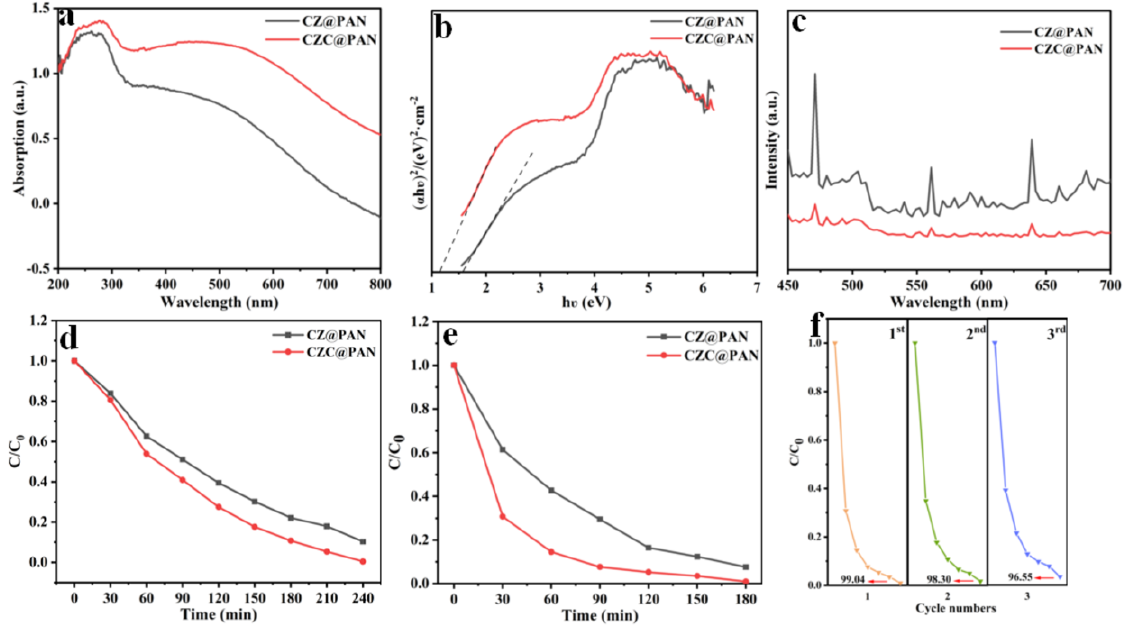
Figure 3. UV-vis spectra ( a ), Tauc plot ( b ), PL spectra ( c ), photocatalytic degradation of MB under natural sunlight ( d ), photocatalytic degradation of MB under mercury lamp ( e ) of samples; Reuse efficiency of CZC@PAN under mercury lamp ( f